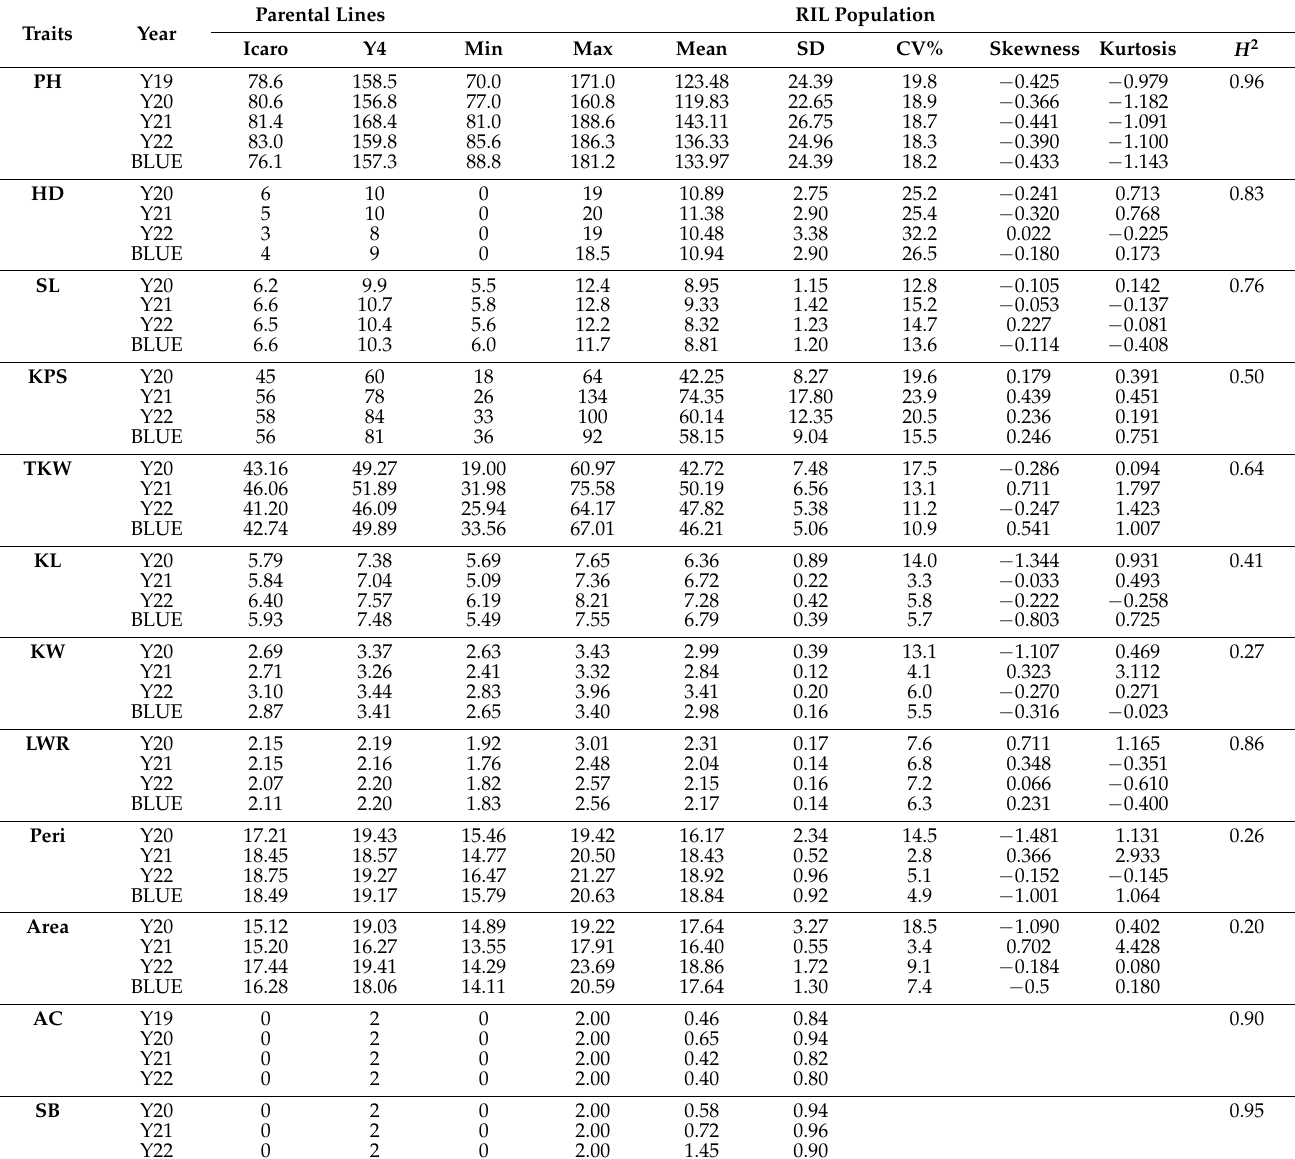
Table 1. Phenotypic variation and heritability of characters in different environments in parents and